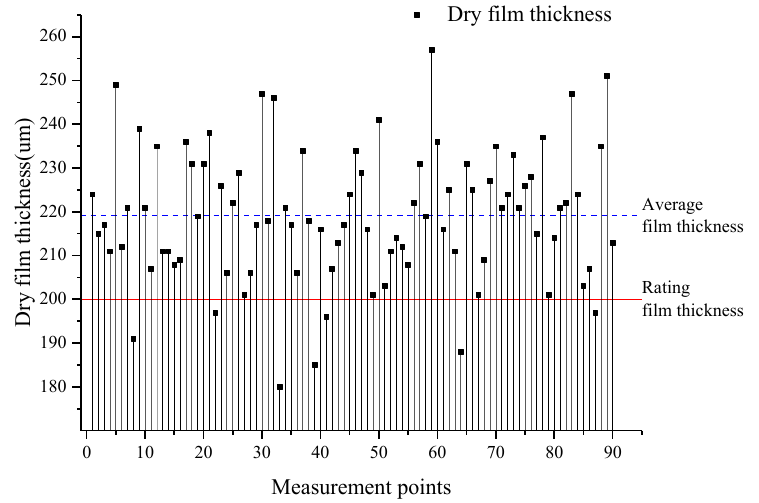
Figure 8. Measurement results of dry film thickness.